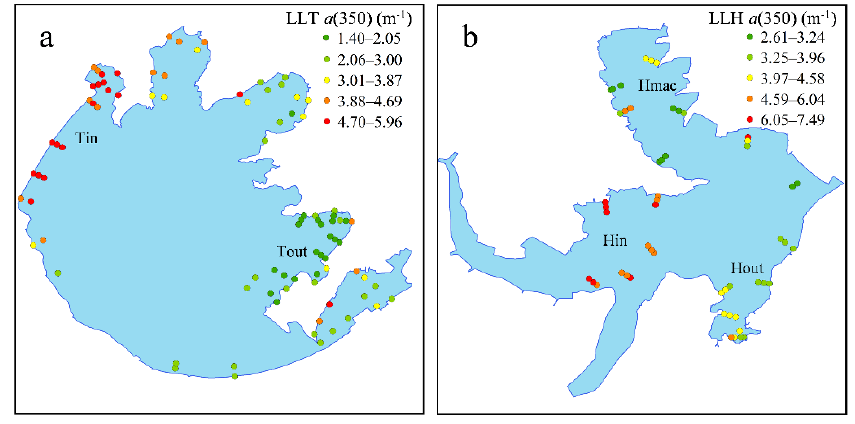
Figure 2. Spatial distribution of a (350) in the littoral zones of Lakes Taihu ( a ) and Hongze ( b ).